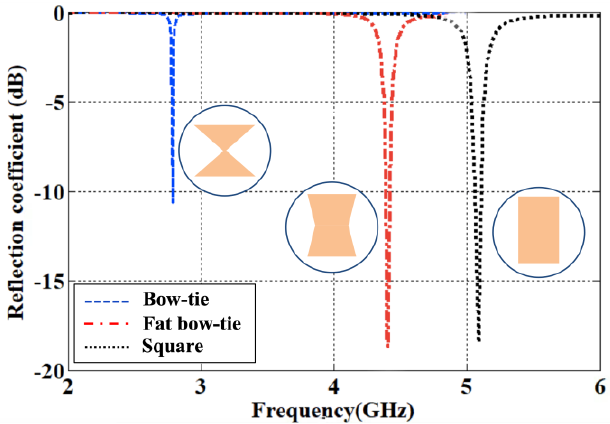
Figure 4. Reflection coefficients of bow tie, fat bow tie and square patch antennas with center frequencies of 2.8 GHz, 4.4 GHz, and 5.1 GHz, respectively. Table 1. Types of antenna elements, their resonant frequencies, and corresponding wireless com- munication services.